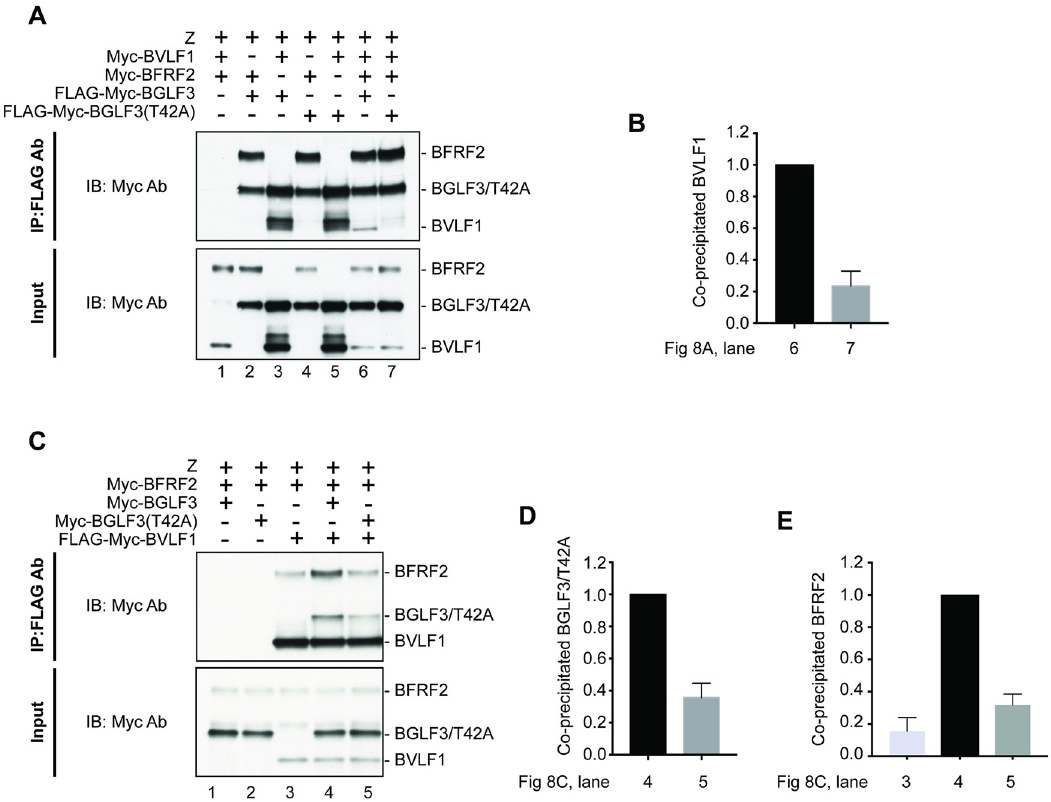
Fig 8. Phosphoacceptor threonine 42 of BGLF3 is necessary for BGLF3, BFRF2 and BVLF1 to form a trimeric complex. Western blot analysis assessing the capacity of BGLF3 to interact with BFRF2 and BVLF1 in the absence and presence of the phosphoacceptor threonine 42 residue. 2089 cells were transfected with the indicated vectors and harvested after 48h. Cleared cell lysates were subjected to immunoprecipitation using anti-FLAG affinity gel followed by Western blot analysis to detect the ability of BGLF3 and BGLF3(T42A) to interact with BFRF2 and BVLF1 individually or together. (A) Immunoprecipitation using FLAG- tagged BGLF3. (B) Quantitation comparing the level of BVLF1 protein co-immunoprecipitated with wild type (lane 6) or mutant (lane 7) BGLF3 in the presence of BFRF2. The level of BVLF1 was corrected to BGLF3 and BGLF3(T42A), respectively. (C) Co- immunoprecipitation of BFRF2 and BGLF3 proteins using FLAG-tagged BVLF1. (D) and (E) quantitation of the level of BGLF3 and BFRF2 proteins that co-precipitate with BVLF1, respectively. Input samples represent 5% of cleared cell lysates. Quantitation is based on two independent experiments. Membranes were blotted with anti-Myc antibody for detection of BFRF2, BGLF3, and